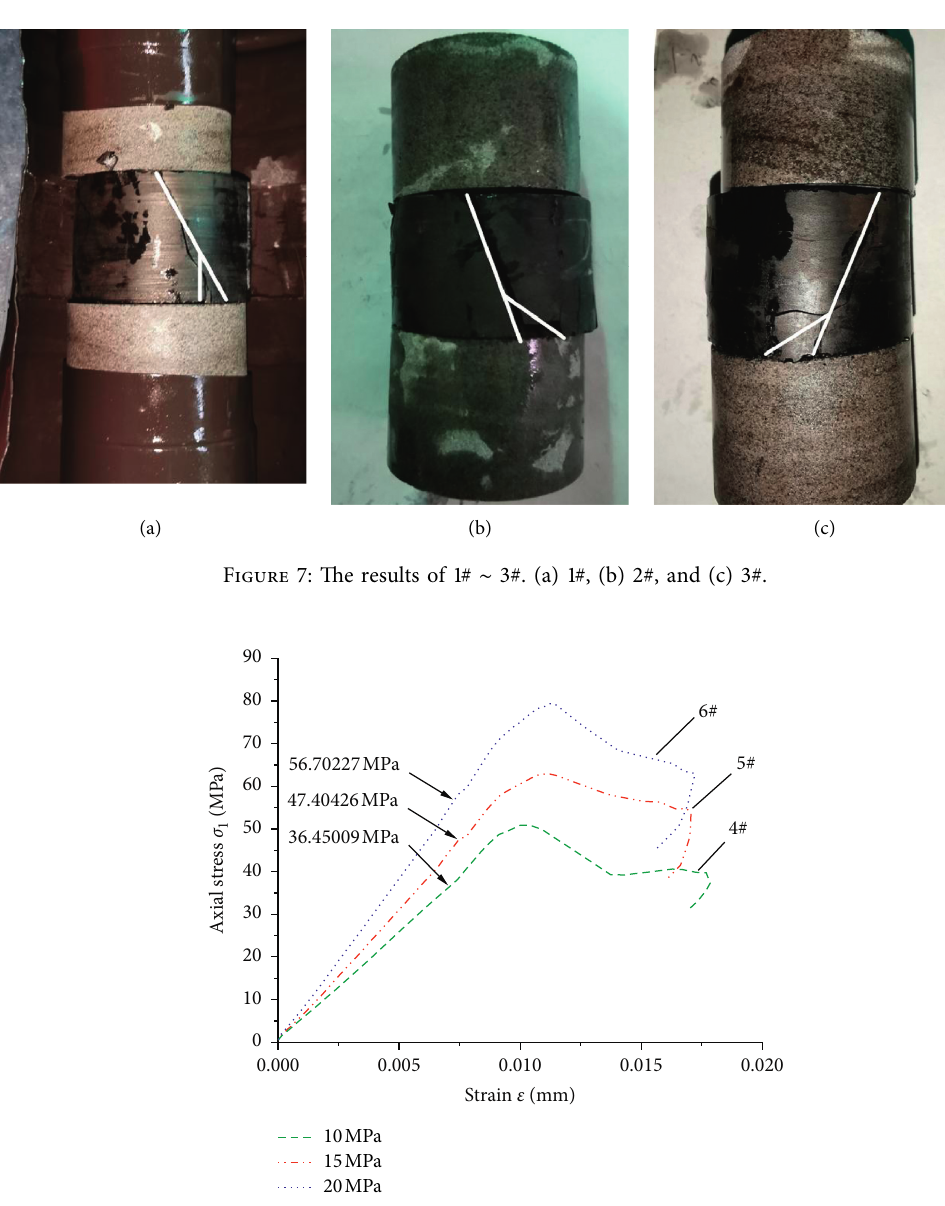
Figure 8: Stress-strain curves under different confining